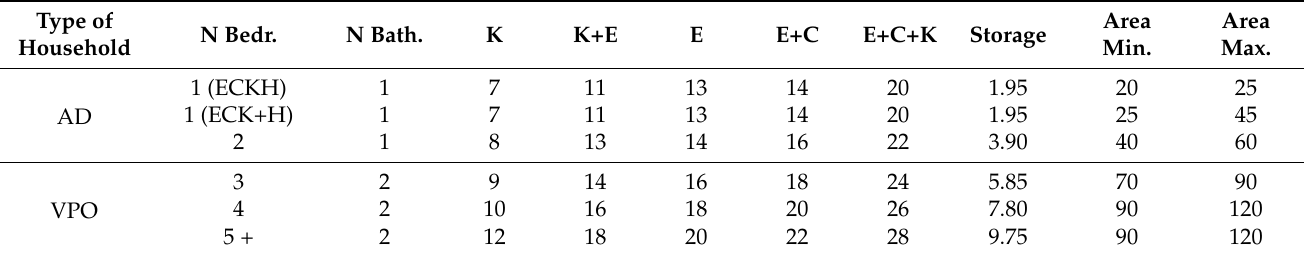
Table 4. Minimum area in square metres of basic-use spaces of dwellings and Ads and their maximum and minimum areas according to the number of rooms.